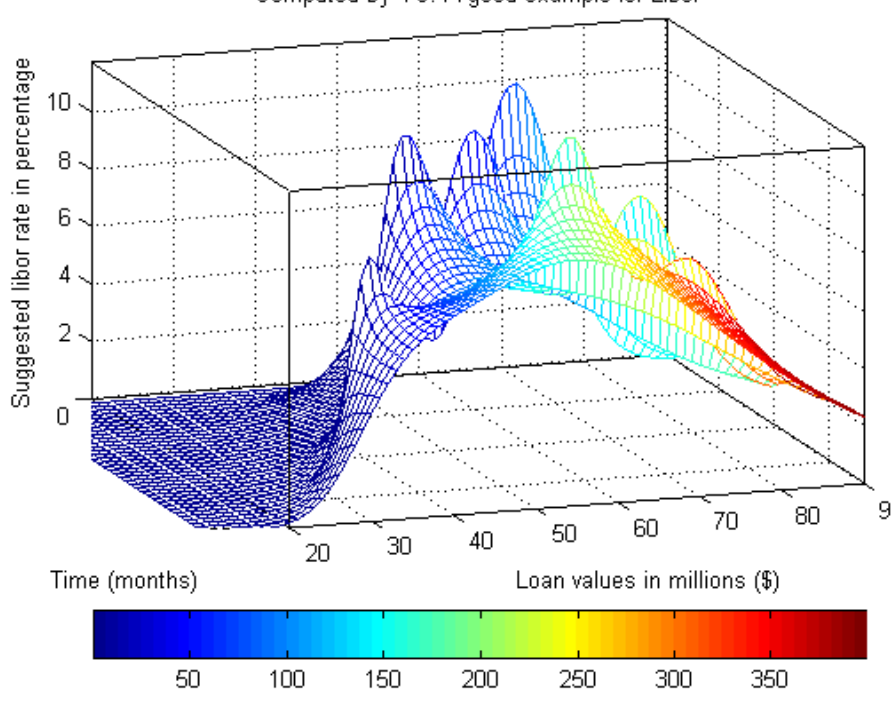
Figure 6. London Interbank Offered Rate (LIBOR) simulations.